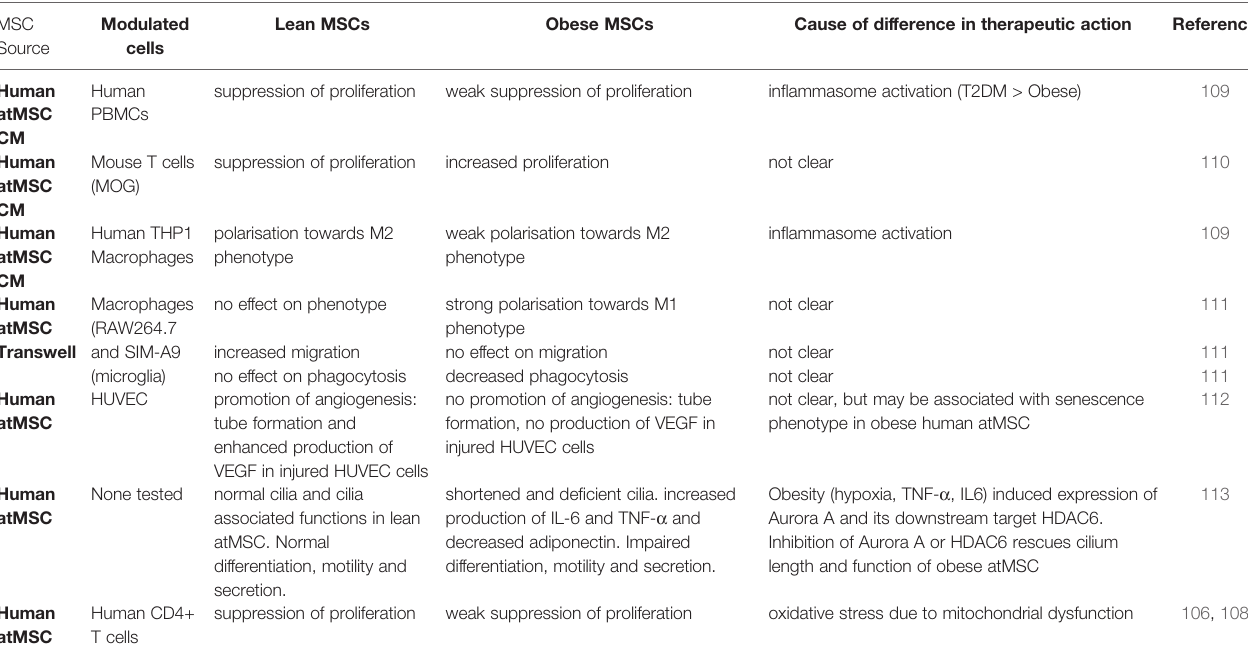
TABLE 2 | Differences in therapeutic action of lean and obese MSCs in vitro